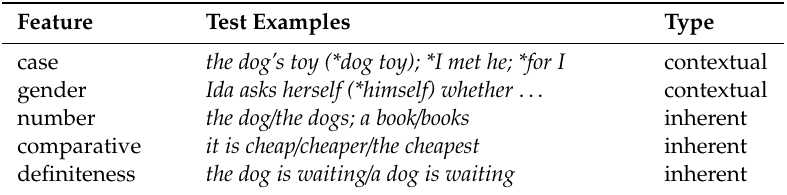
Table 1. The assignment of nominal categories.